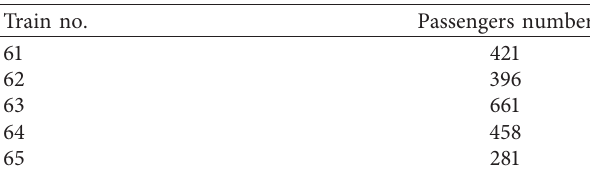
Table 7: The number of passengers on each train (person). Train